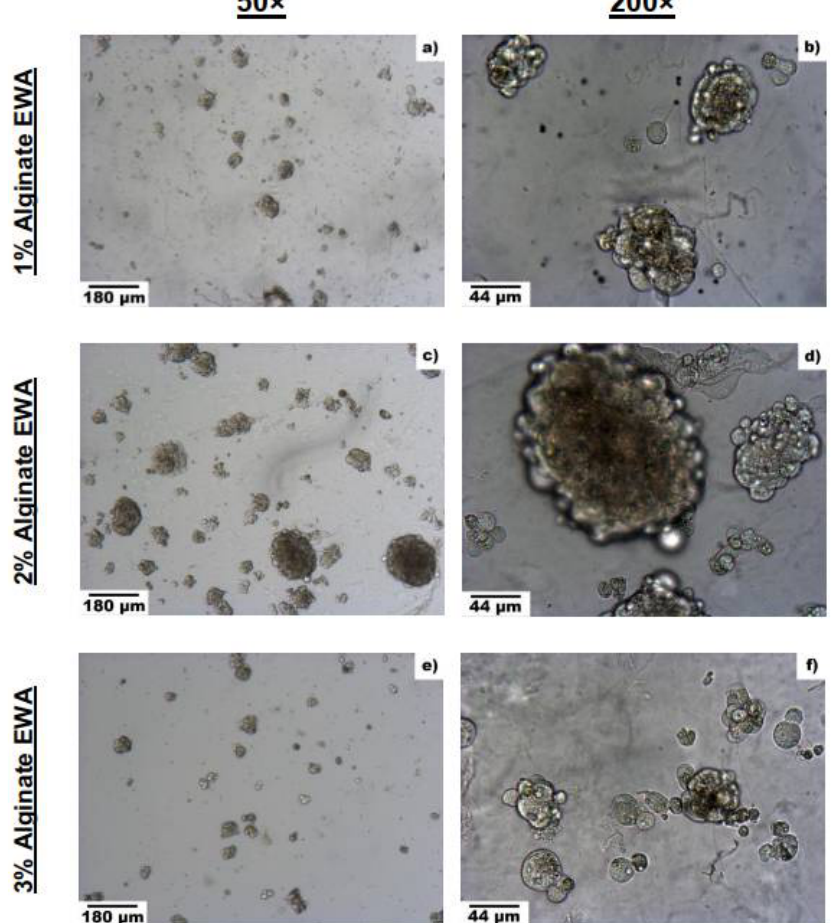
Figure 2. Images of NS-SV-AC grown on EWA at 1%, 2%, and 3% alginate on day 5: Images ( a ) and ( b ) represent NS-SV-AC grown on 1% alginate EWA, taken at 50× and 200× respectively. Likewise, images ( c ) and ( d ) represent NS-SV-AC grown on 2% alginate EWA at 50× and 200×, and images ( e ) and ( f ) represent NS-SV-AC grown on 3% alginate EWA at 50× and 200×.